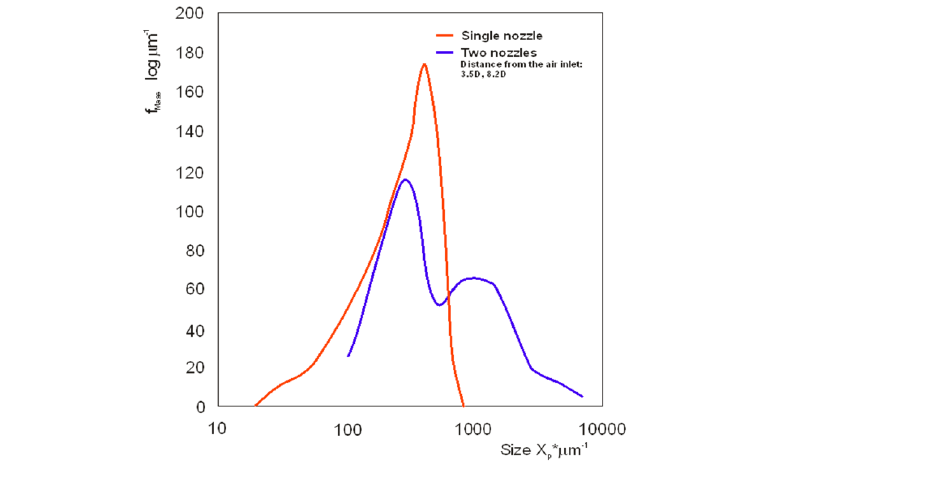
Figure 8. Product size distribution for single- and multi-nozzle operation (3.5D and 8.2D from air inlet).